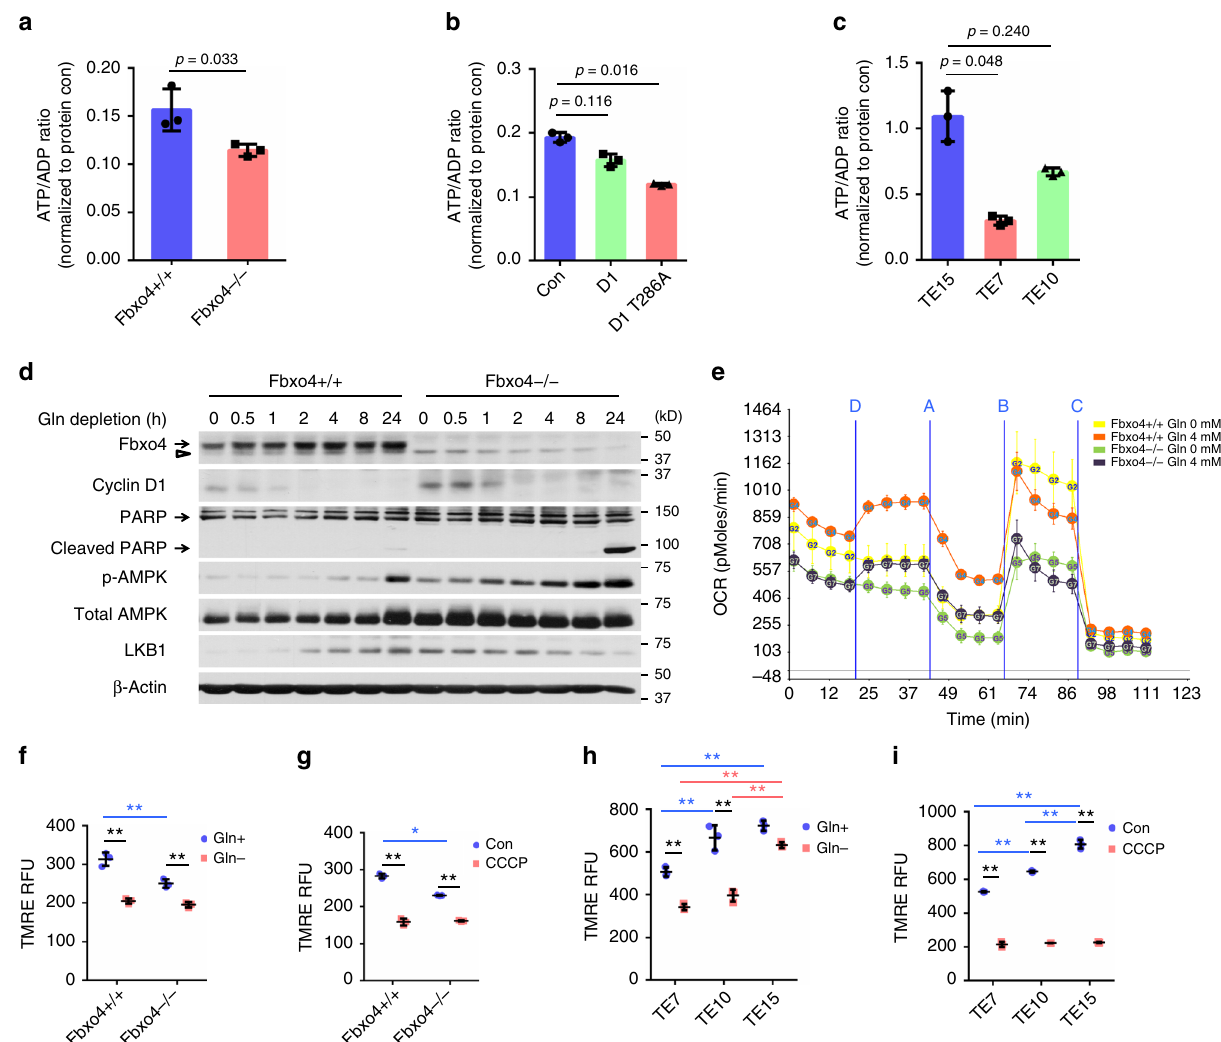
Fig. 4 Cyclin D1 accumulation promotes mitochondrial dysfunction. a – c ATP/ADP ratio in Fbxo4 + / + and − / − mouse embryonic fi broblasts (MEFs) ( a ), NIH3T3 cells ( b ), and esophageal squamous cell carcinoma (ESCC) cells ( c ) detected by ApoSENSOR ™ ADP/ATP ratio bioluminescent assay. a Data represent as mean ± s.d., two-tailed Student t- test was used to compare means ( n = 3); b , c Data represent as mean ± s.d., one-way ANOVA was used to compare means with Bonferroni as Post Hoc test ( n = 3); p- values are listed. d Western analysis for the indicated proteins in Fbxo4 + / + versus − / − MEFs upon Gln-depletion. Arrow: band of interest; open triangle: non-speci fi c band. e Seahorse analysis for Fbxo4 + / + and − / − MEFs; data were normalized to protein concentration. Injections: Port D: Gln; Port A: Oligomycin; Port B: Carbonyl cyanide-4-(tri fl uoromethoxy)phenylhydrazone (FCCP) and Port C: Antimycin A & Rotenone. f, g Mitochondrial membrane potential analysis of Fbxo4 + / + and − / − MEFs; g Carbonyl cyanide m-chlorophenyl hydrazone (CCCP) treatment as positive control. h , i Mitochondrial membrane potential analysis of TE7, TE10, and TE15 cells; i CCCP treatment as positive control. TMRE, tetramethylrhodamine, ethyl ester; RFU, relative fl uorescence units. All data in f – i represent as mean ± s.d., one-way ANOVA was used to compare means with Bonferroni as Post Hoc test ( n = 3). * p < 0.05; ** p < triggered increased phosphorylation of p70S6K1, S6 and 4EBP1 in NIH3T3 cells (Fig. 3c). In addition, dysregulation of Fbxo4- malian target of rapamycin complex 1 (mTORC1), a critical cyclin D1 also promoted more mTORC1 activation in TE7 and sensor of extracellular stimuli and nutrient levels, functions as a TE10 cells compared to TE15 cells; furthermore, increased basal central regulator to balance cell proliferation/growth and the mTORC1 activation was also detected in TE7 and TE10 cells availability of nutrients 31,32 . Dysregulation of mTORC1 signaling (Fig. 3d). These data demonstrate mTORC1 signaling is hyper- has been observed in pathological conditions, including cancer, activated in cells with cyclin D1 overexpression. obesity, diabetes, and neuro-degeneration 33 . Cyclin D1-CDK4/6 phosphorylates and inactivates TSC1/2, resulting in the activation We next assessed the relevance of elevated mTORC1 activation of mTORC1 signaling 34,35 . Consistent with frequent over- with Gln-addiction in cells harboring dysregulated Fbxo4-cyclin expression of cyclin D1 in ESCC, GSEA revealed mTORC1 D1 axis. Cells were exposed to Gln-free medium; meanwhile, activation in ESCC relative to normal tissues (Fig. 3a, b and compounds or genetic manipulations were applied to compro- Supplementary Tables 5 – 6). To test whether mTORC1 is induced mise mTORC1 activity. Consistent with mTORC1 inhibition, by cyclin D1, NIH3T3 or ESCC cells were exposed to Gln- both rapamycin and Rad001, partially suppressed cell apoptosis withdrawal. Analysis revealed that cyclin D1 overexpression as determined by reduced cleavage of both PARP and caspases-3